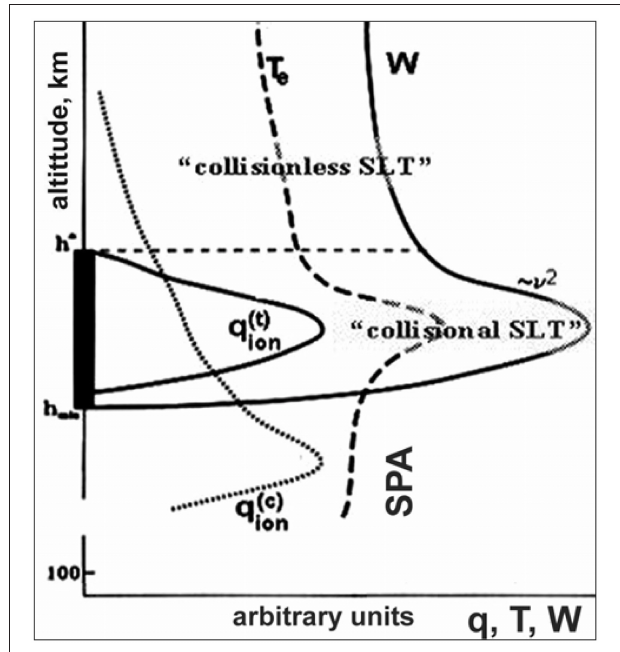
FIGURE 11 | Schematic representation of the Plasma Turbulence Layer (PTL) indicated by the black rectangle and a double-peaked ionization profile. The dotted curve presents the collisional (SPA) ionization profile, q ( c ) ion . The dashed curve shows the electron temperature profile of the heated plasma. The solid curves show the altitudinal profiles of the wave energy density, W , and ionization rate of the accelerated electrons, q ( t ) ion . The dashed horizaontal line indicates the PTL upper boundary. After Mishin (2010). Reprinted by permission from the American Institute of